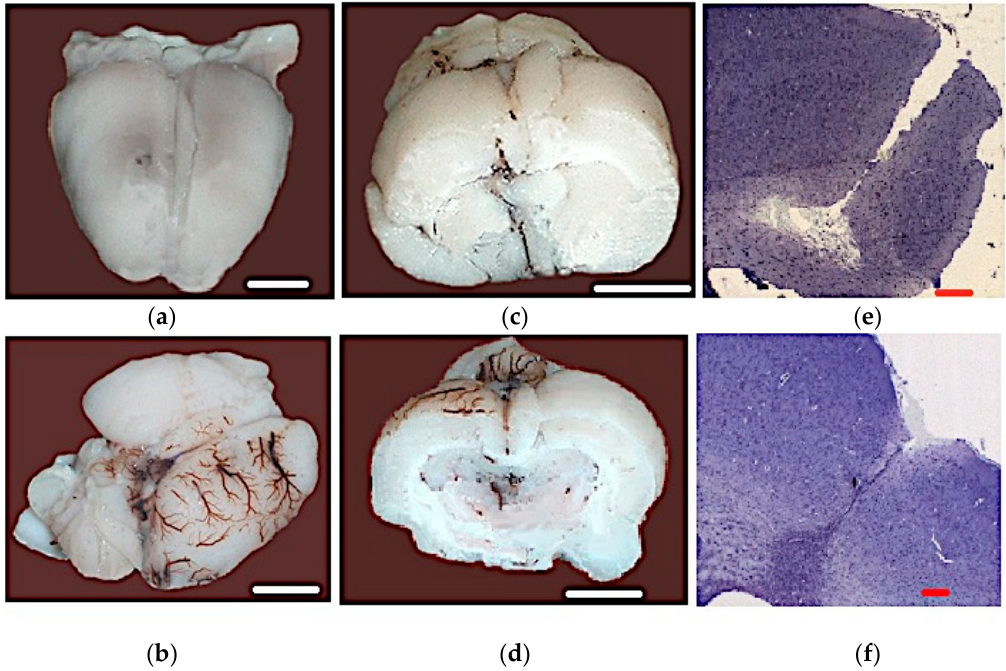
Figure 2. Macro-and microscopic structure of the dead animal brains. ( a – d ) Hemorrhages in the structure of the brain; ( e , f ) hemorrhage in the capsula interna area: hematoxylin–eosin staining (20 × ). The lines in the figures represent the scale: white lines—35 mm; red lines—100 microns.